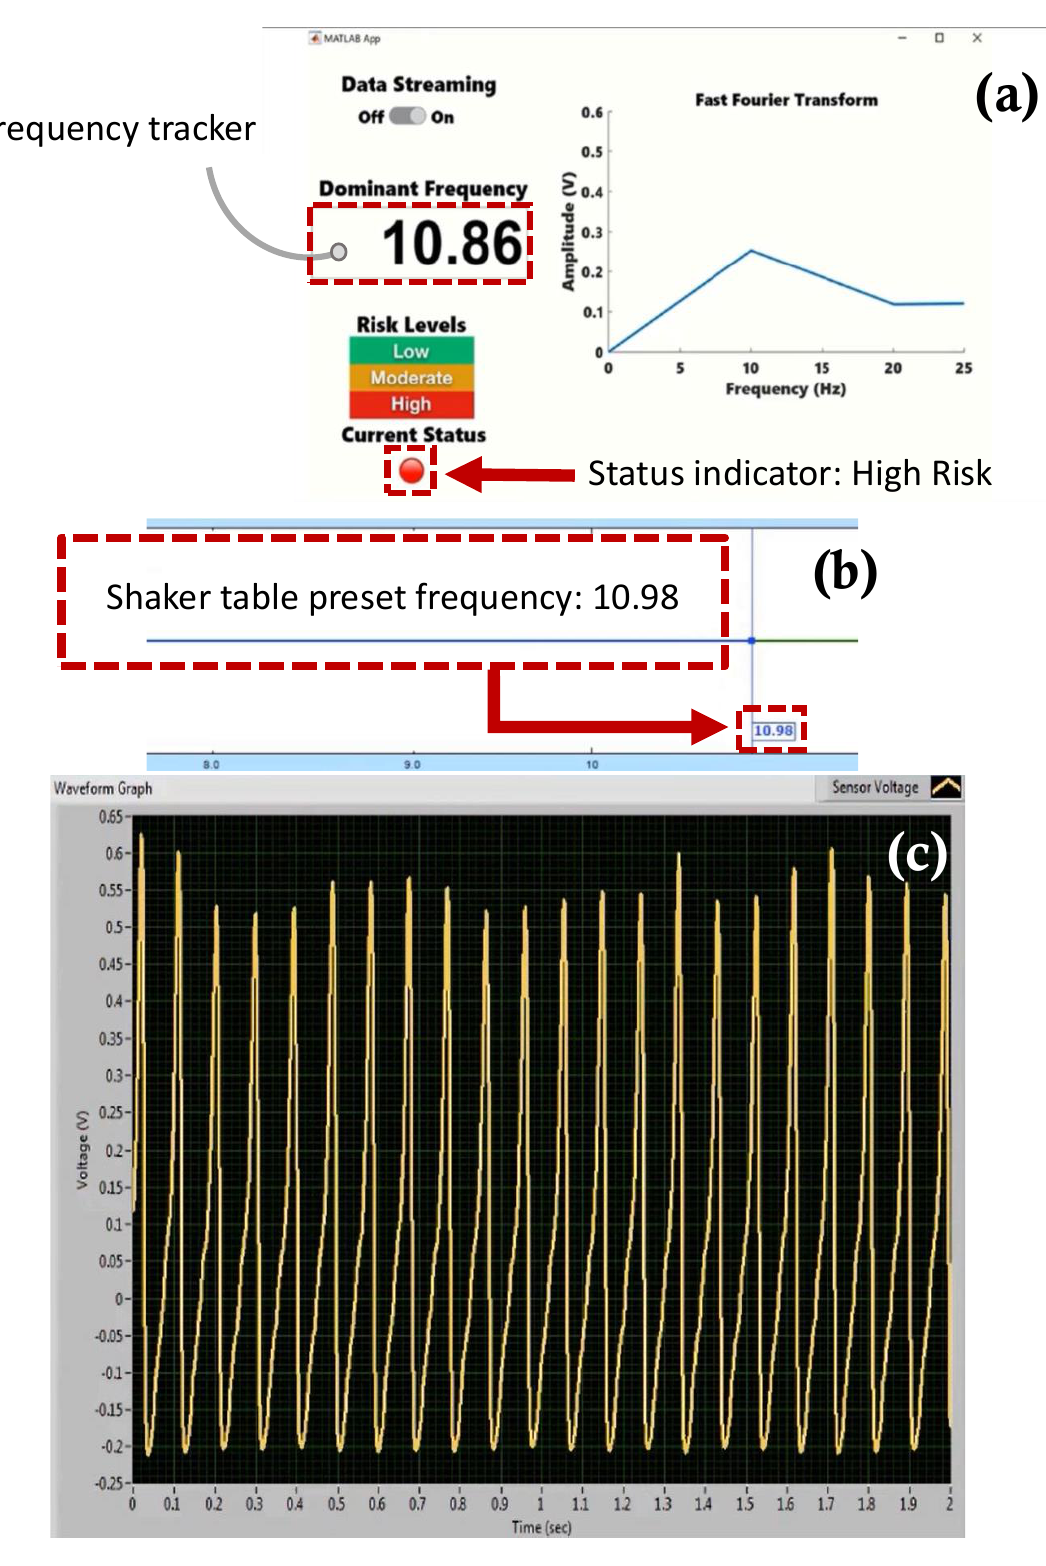
Figure 19. Screen captures of the self − powered, self − contained, vibration sensor system taken from the demonstration experiment: ( a ) custom developed fault detection app with a frequency tracker feature and status indicator for risk monitoring, ( b ) EDM shaker table vibration control software with preset frequency monitor, and ( c ) sensor voltage waveform monitor at preset frequency 10.98 Hz.